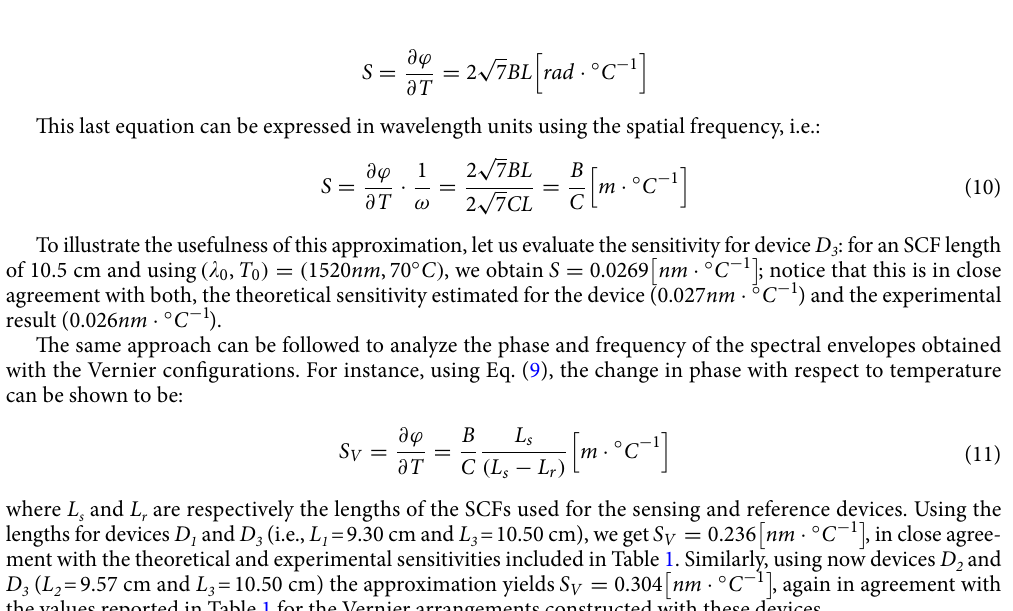
Figure 4. The coupling coefficient of the SCF as a function of temperature for three different